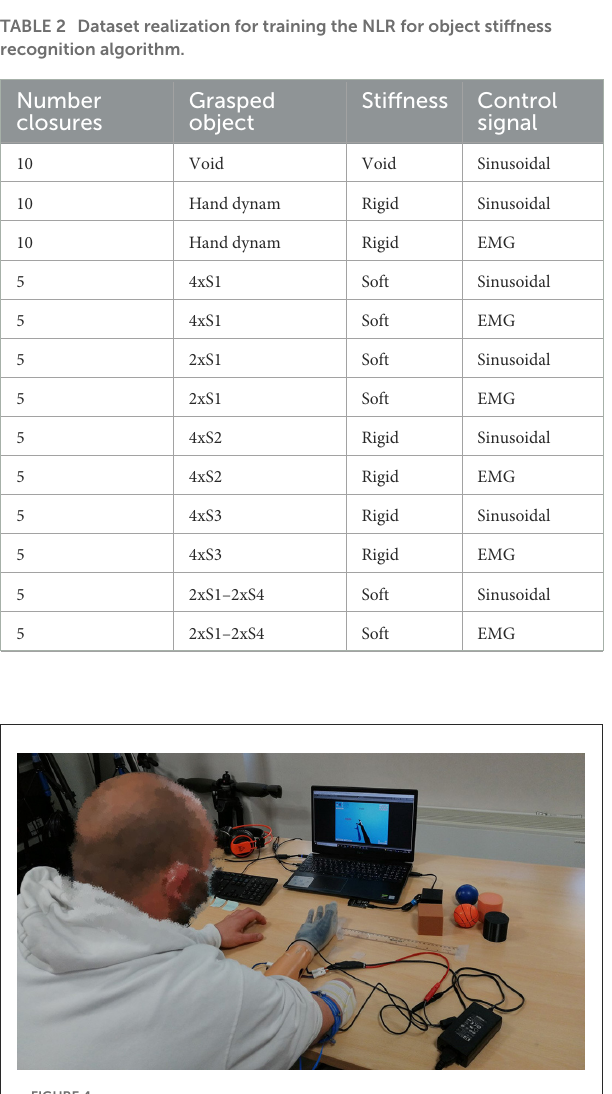
FIGURE4 Example of trial involving an amputee. Two EMGs are attached to the stump for the dual-side control of the prosthesis with an elastic band. The vibromotor is fixed to the upper side of the stump with a second elastic band for the feedback restitution. The objects are placed within Hannes hand by the experimenter while the participant has closed eyes. The keyboard, placed in front of the participant, is used to indicate the grasped object stiffness by the user using the left